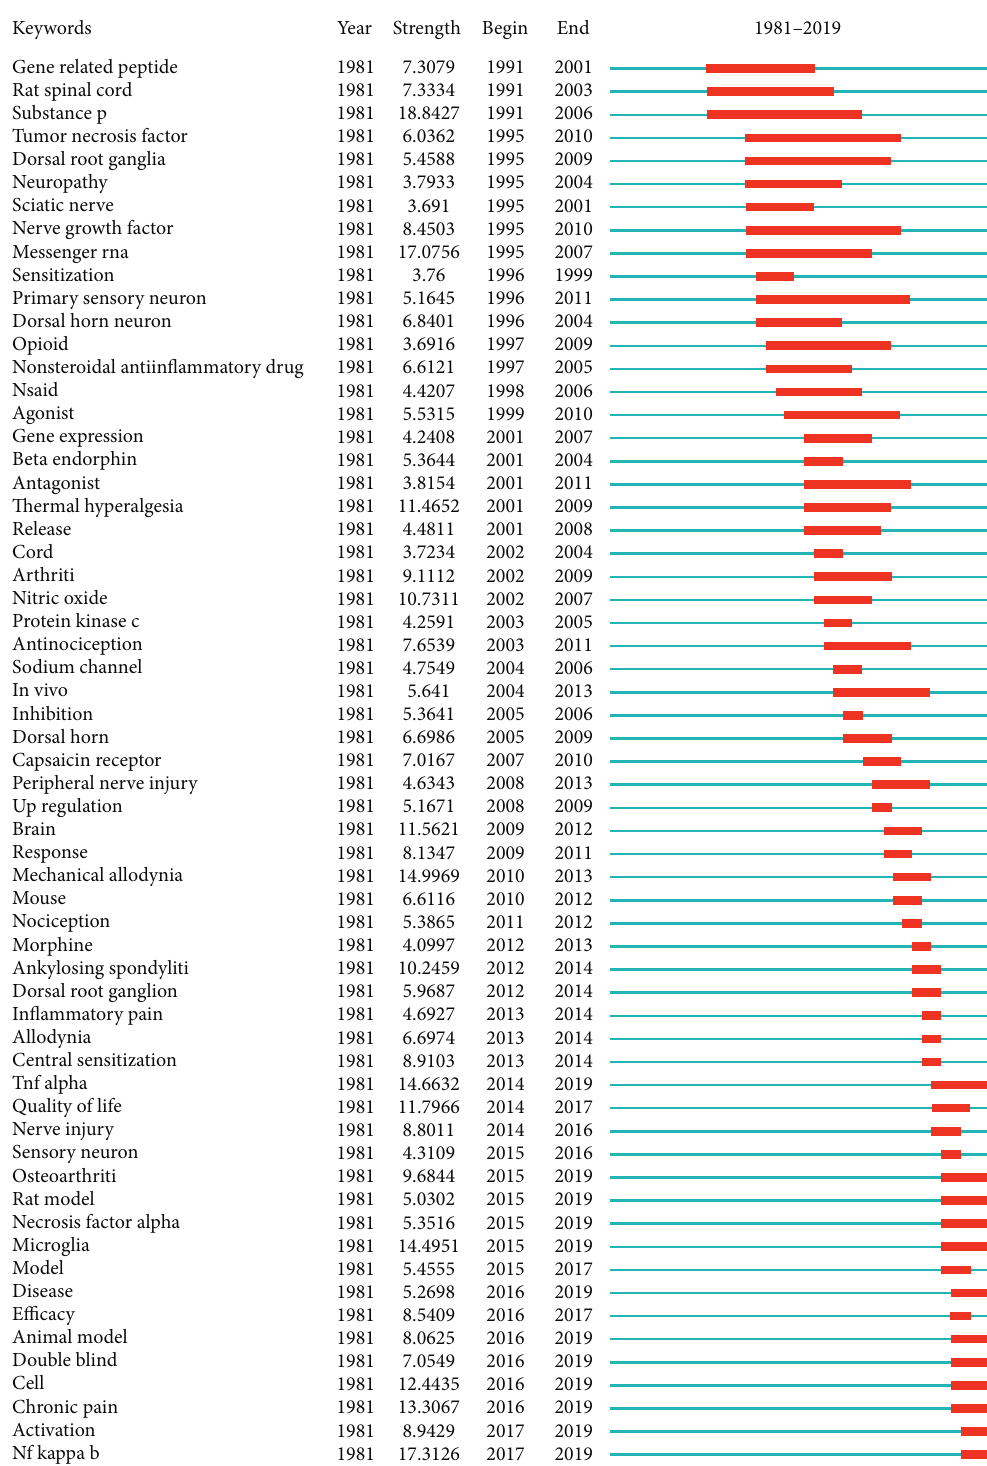
Figure 11: The keywords with the strongest citation bursts of publications on pain and inflammation